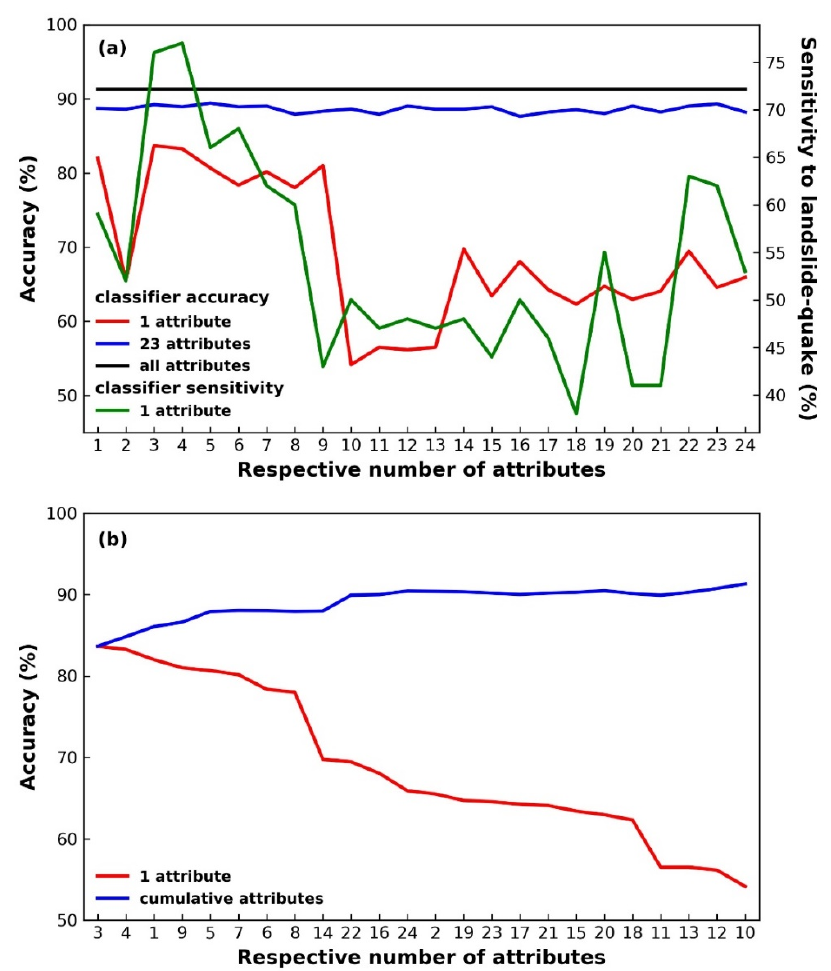
Figure 9. Performance of 24 attributes in classification. ( a ) Accuracy for 24-attribute, 23-attribute, and single-attribute classification; ( b ) accuracy for cumulated number of attributes. Table 4. Performance of the classifiers created with different sets of features and validation to two typhoons.